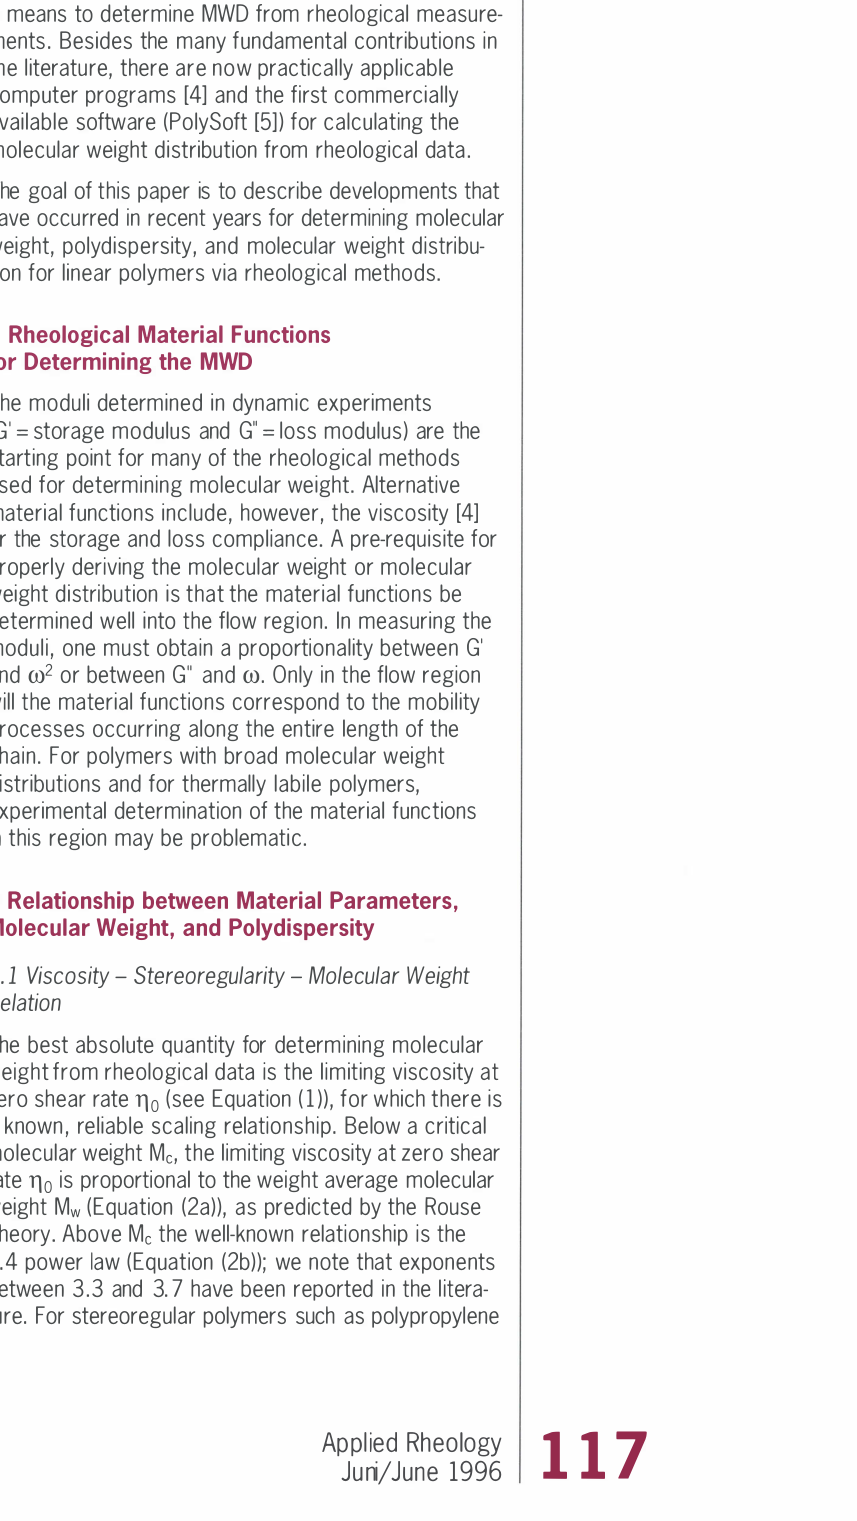
Fig.l. Log-log plot of the limiting viscosity at zero shear rate 11 o vs. weight average molecular weight Mw for two series of PMMA with different tacticity (Tret = 190 oC) and isotactic and syndiotactic PP (Tref =